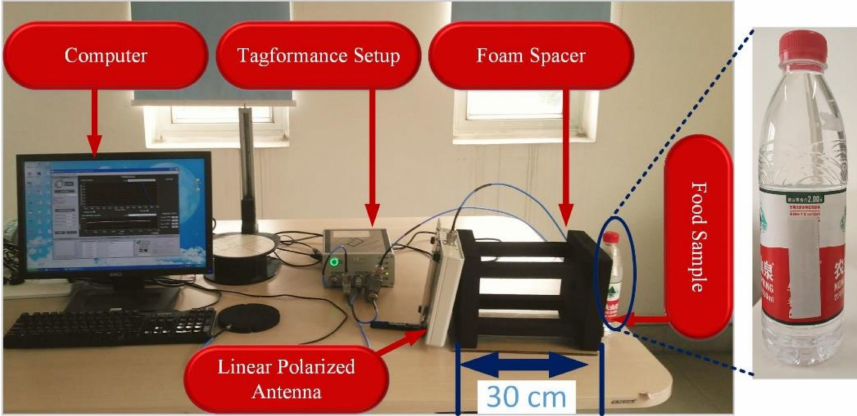
Figure 3. Tagformance Pro based setup for food contamination sensing.